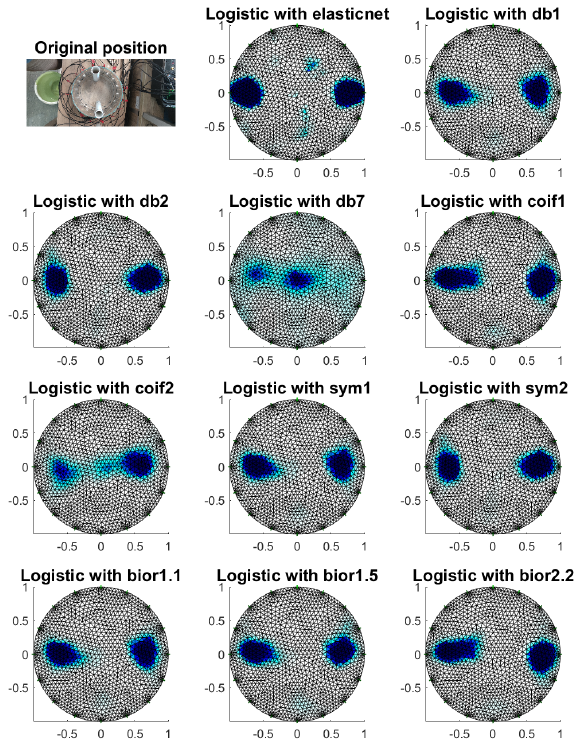
Figure 19. Image reconstruction with phantoms at electrodes 5 and 13.